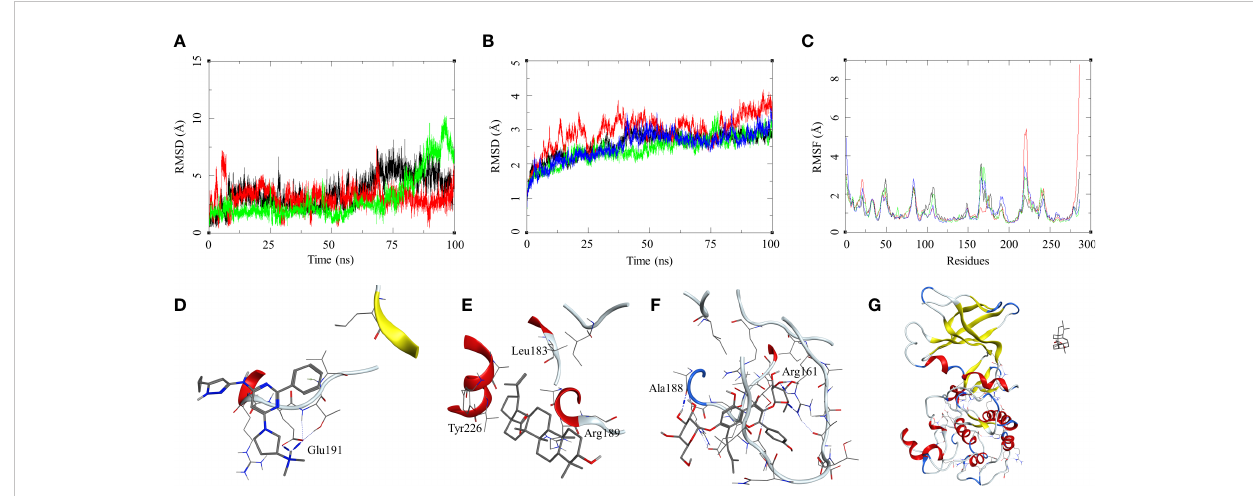
FIGURE 5 Molecular dynamics simulation results for M. smegmatis serine/threonine-protein kinase (STPK): (A) ligand RMSD for MRCT67127 (black), BA (red), and IC (green); (B) ligand-bound protein RMSD for MRCT67127 (black), BA (red), IC (green), and UA (blue); (C) ligand-bound protein RMSF for MRCT67127 (black), BA (red), IC (green), and UA (blue). Protein – ligand complex poses at the end of the 100-ns simulations, (D) STPK – MRCT67127, (E) STPK – BA, (F) STPK – IC, and (G) STPK –